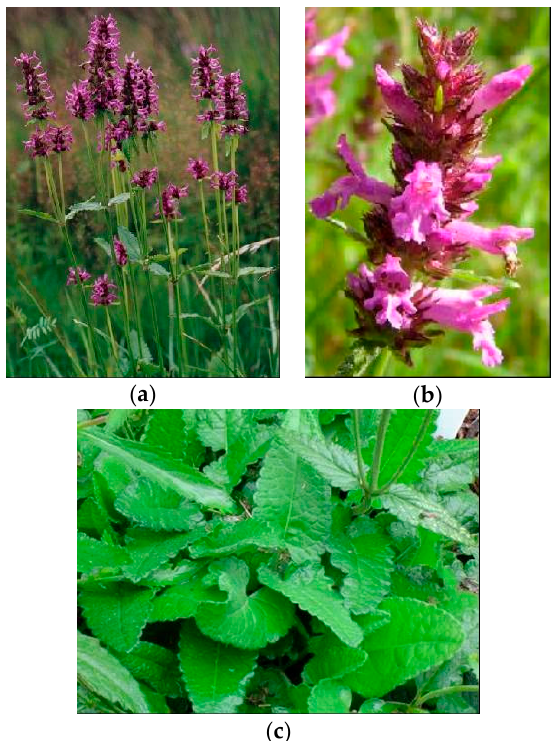
Figure 2. S. officinalis L. ( a ) plant in flowering stage; ( b ) detail of the flower; ( c ) detail of leaf.